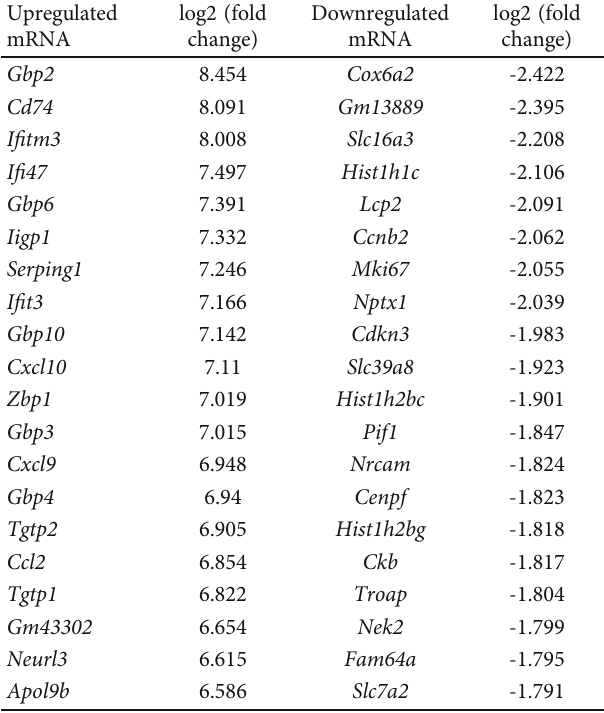
Figure 1: Changed expression pattern of mRNAs in cytokine-mediated pancreatic β -cell destruction. (a) The heat map of di ff erentially expressed mRNAs in pancreatic β -cells treated with a mix of cytokines, including IL-1 β , TNF- α , and IFN- γ , compared with control cells from RNA sequencing data. (b) Volcano analysis showing di ff erentially expressed mRNAs in cytokine-treated pancreatic β -cells and control cells. Table 1: The top 20 upregulated and downregulated